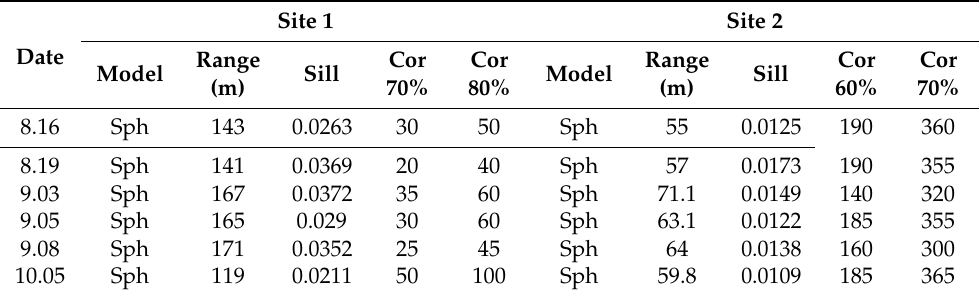
Table 2. Sill and range of the NDVI images and the number of sample points required when the sampling efficiency of two sites reaches 70% and 80% at the two